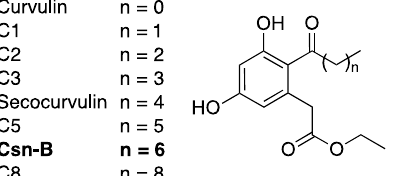
Figure 6. Analogs of cytosporone B (Csn-B) synthesized and analyzed for T3SS inhibitory activity by the Shen